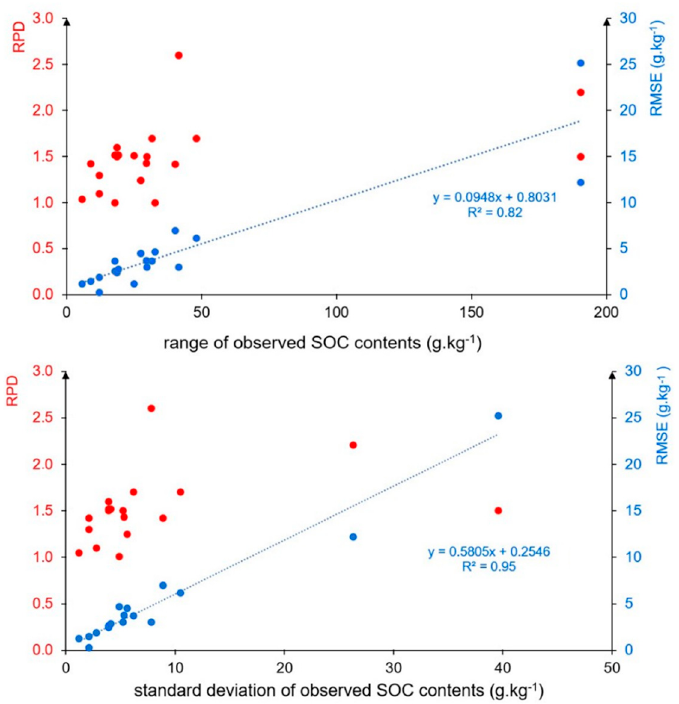
Figure 5. Plot of performance indicators versus range ( top ) or standard deviation ( bottom ) of measured SOC contents for PLSR models [26,31,34,36,44,48–50,54,55,58,67].